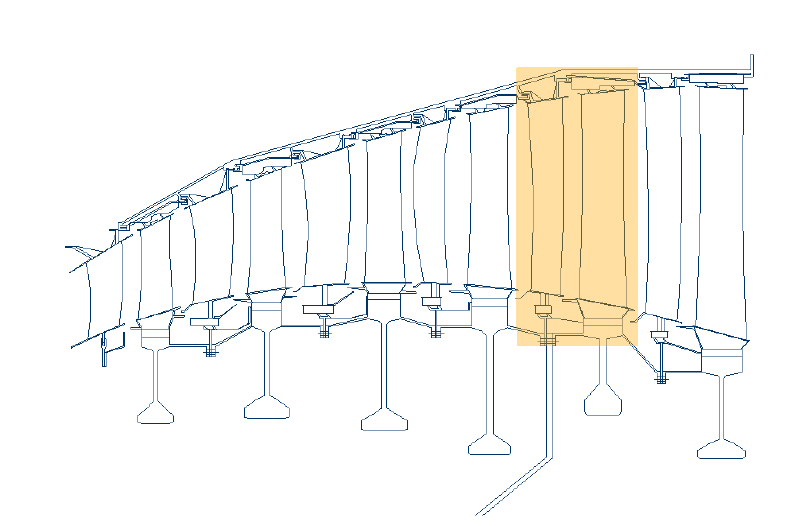
Figure 3. LPT module.